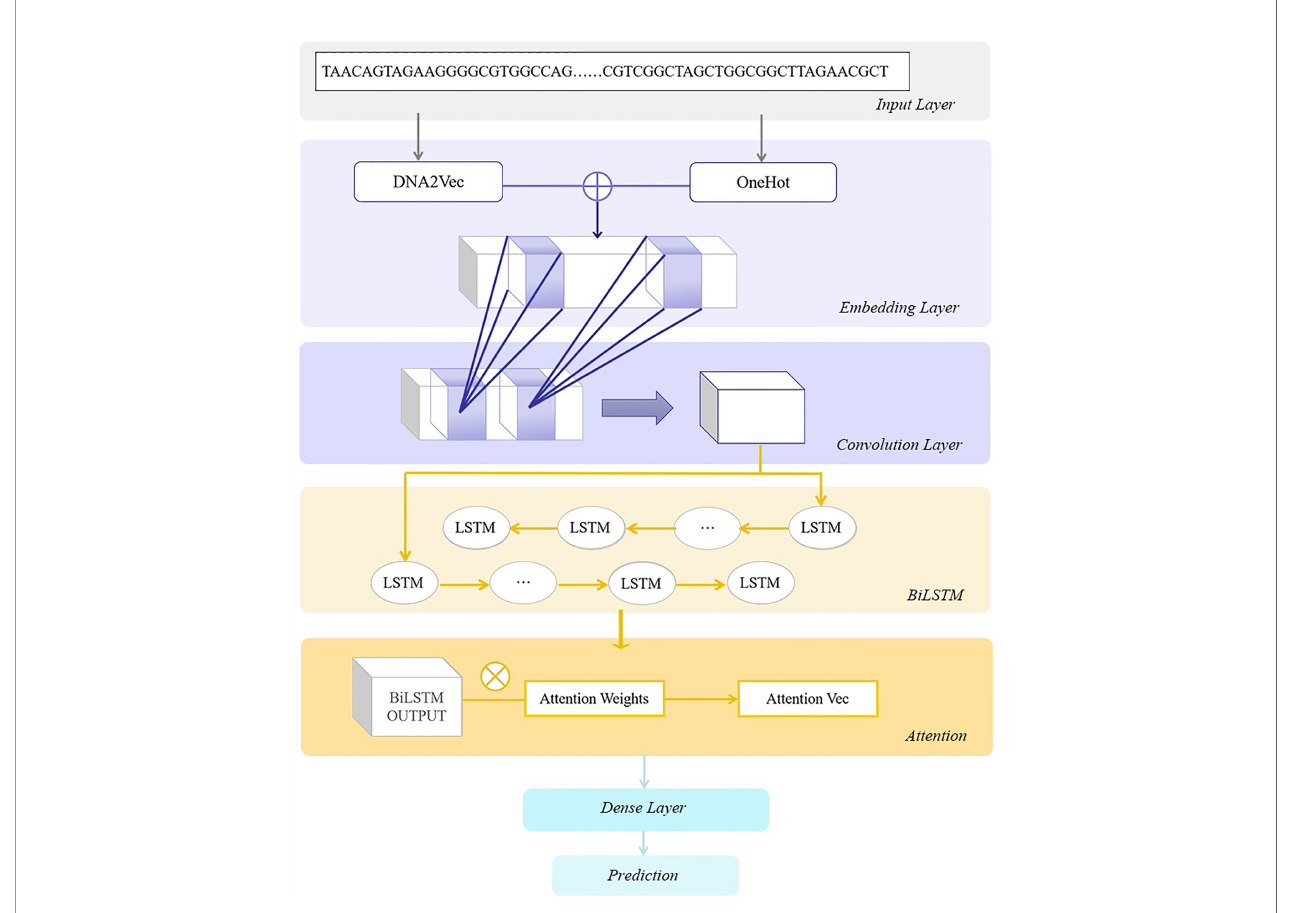
FIGURE 1 | The architecture of DeepARC. In the embedding layer, OneHot and k-mer encoding are used to generate position-based feature embedding from DNA sequences. Then convolution kernels are utilized to extract non-linear features. In the BiLSTM layer, we use a bidirectional long short-term memory network (BiLSTM) to capture the contextual dependencies of DNA sequences. Next, we use the attention mechanism to enhance the model ’ s prediction performance, and fi nally, the prediction results are obtained through the dense